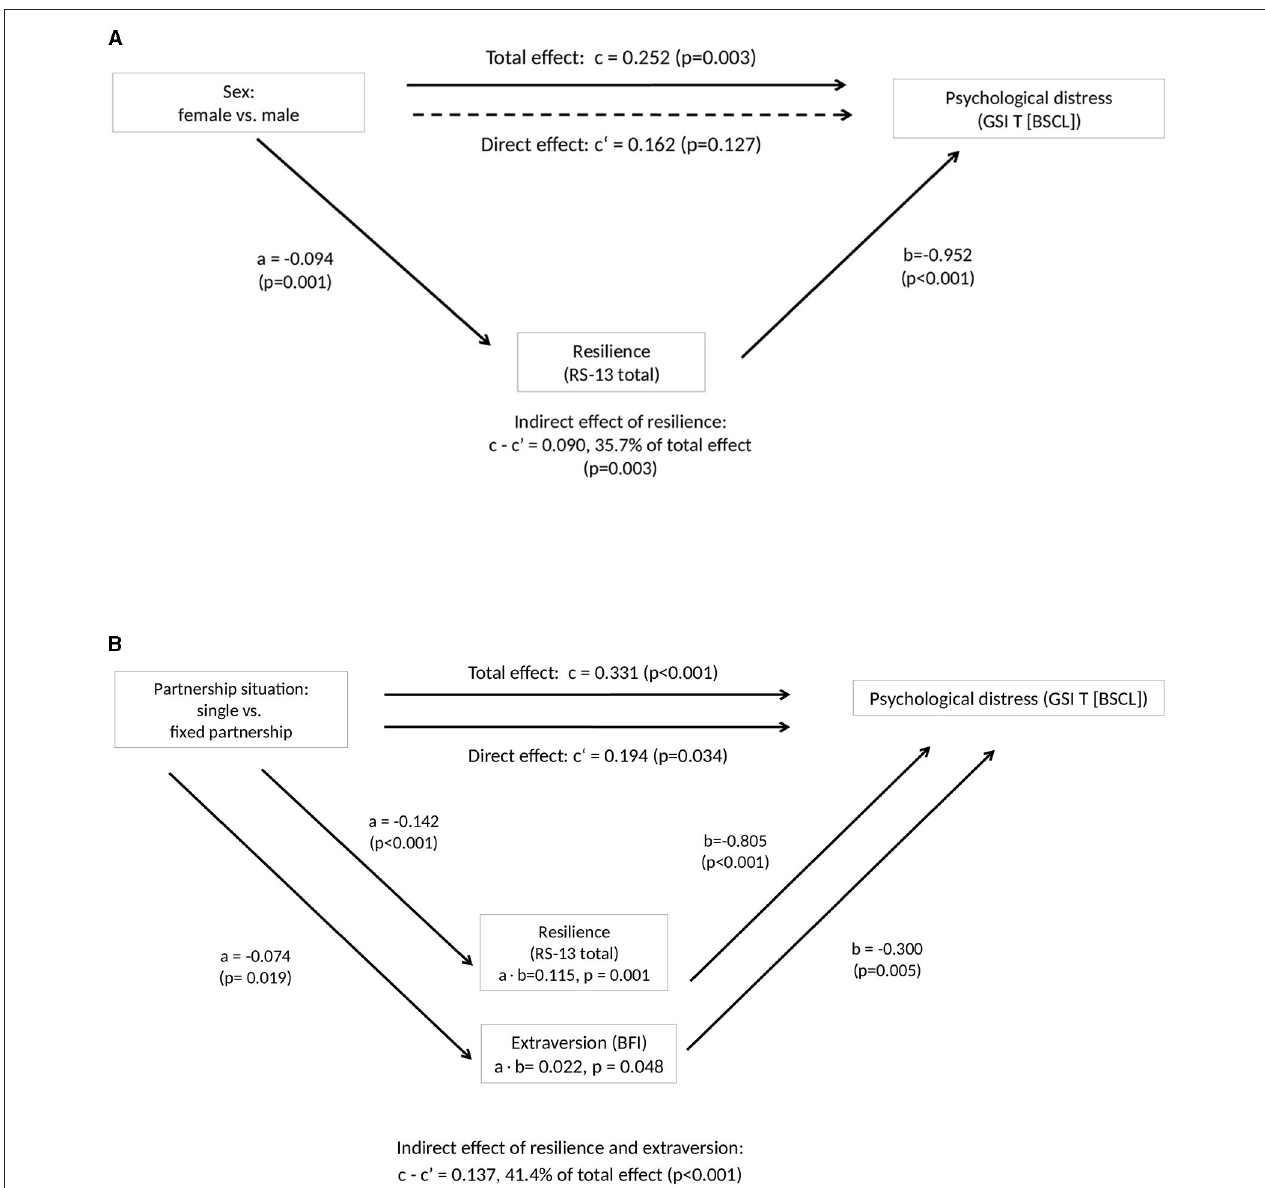
FIGURE 1 | Findings of mediation analyses 1, dependent variable psychological distress. (A) Effect of resilience as a mediator on the relationship between sex and psychological distress. Numbers shown are standardized regression coefficients. Solid lines indicate statistically significant effects, dashed lines indicate non-significant effects. Extraversion (BFI total score) did not show a significant mediation effect. (B) Indirect effect of resilience and extraversion on the relationship between partnership situation and psychological distress. Numbers shown are standardized regression coefficients. Solid lines indicate statistically significant